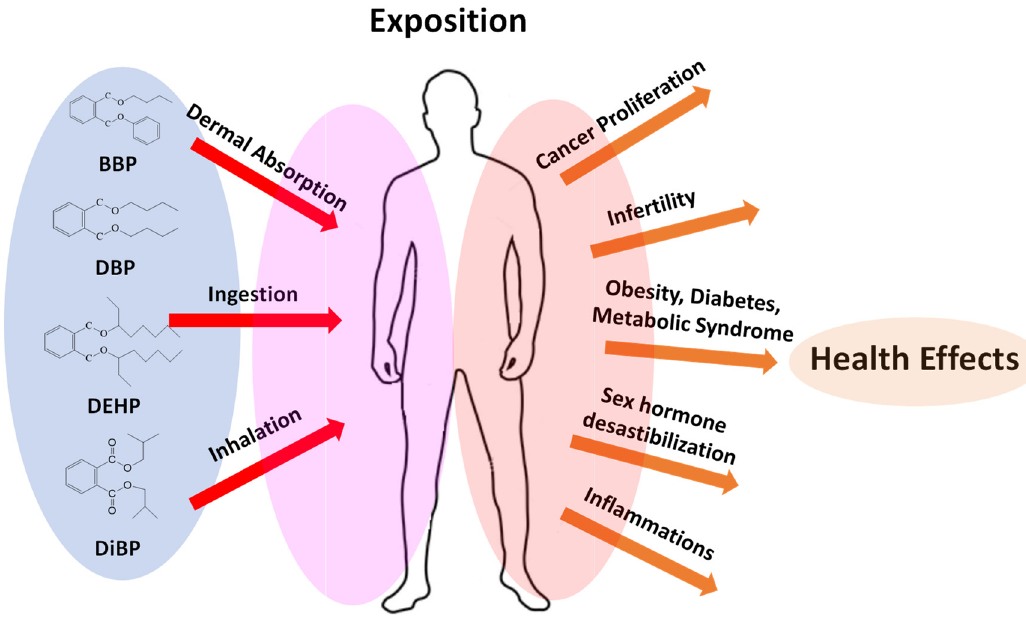
Figure 2. Human exposition to phthalates and their health effects.